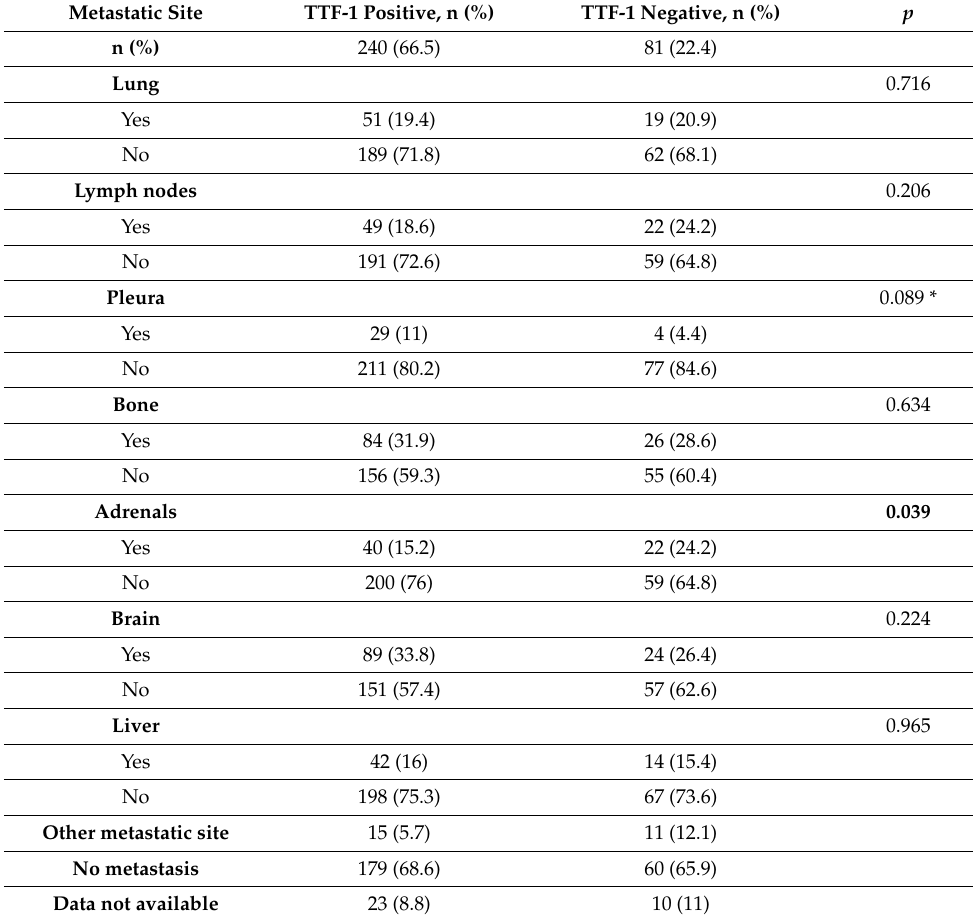
Table 1. Metastatic sites according to TTF-1